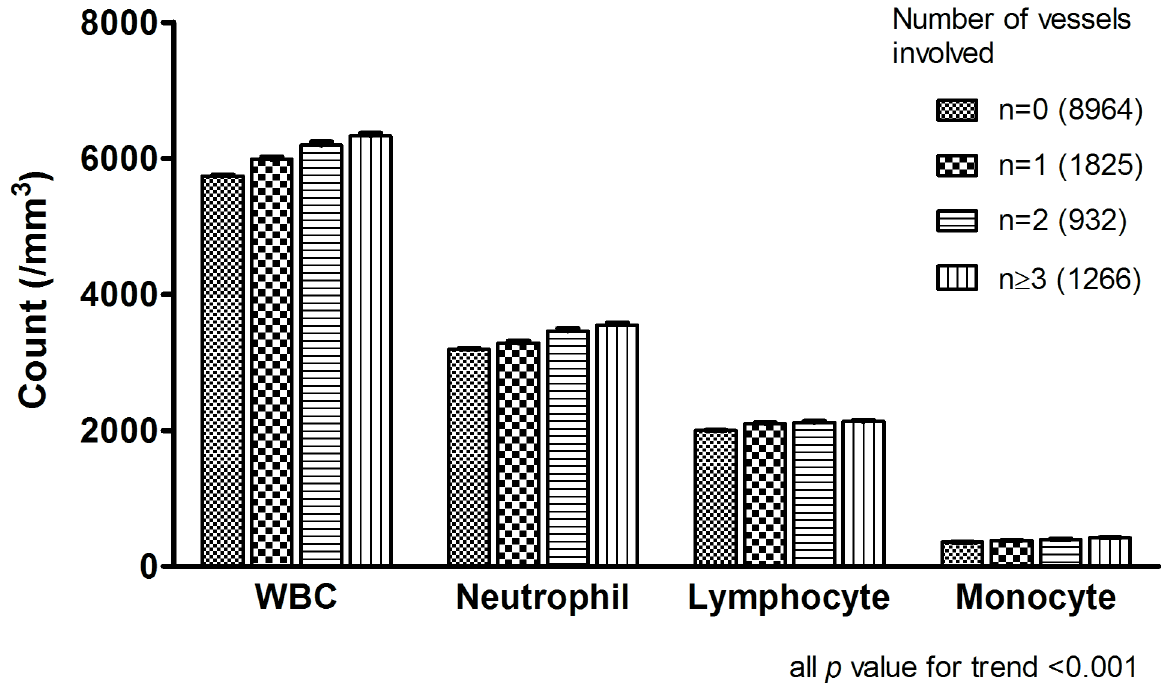
Fig 2. The number of each WBC subtype according to the number of vesselsinvolved. (all p value for trend < 0.001).